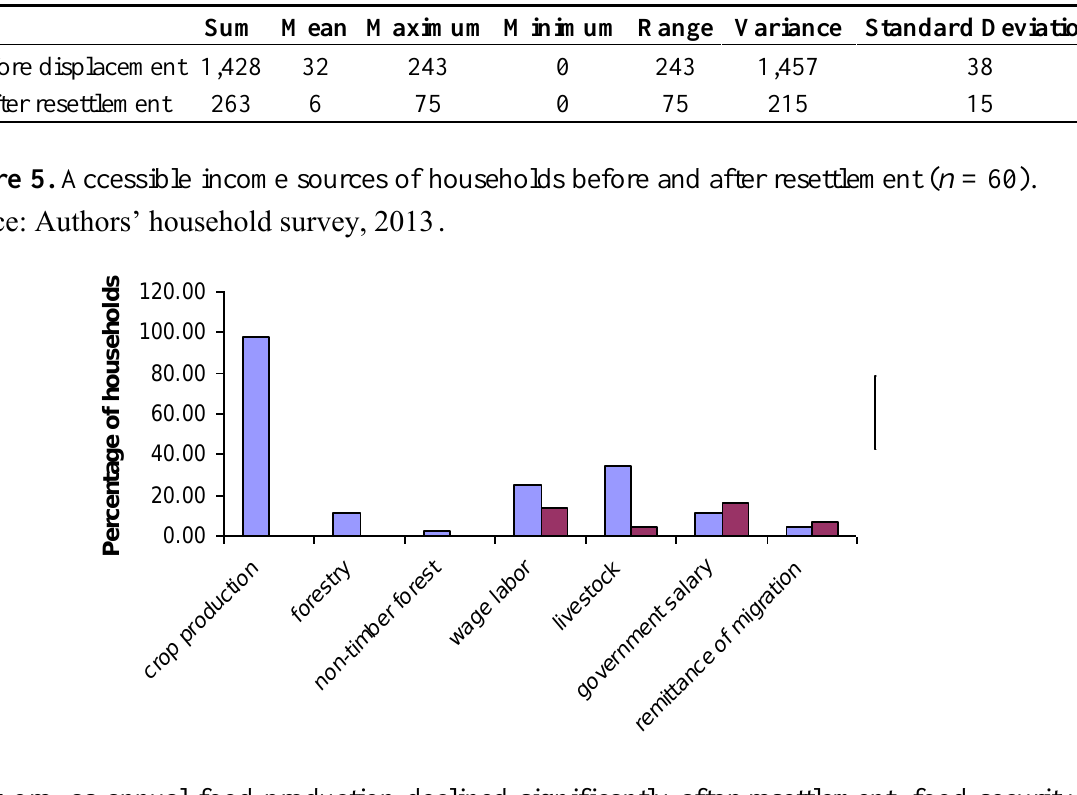
Table 2. Household income distribution before and after resettlement. Unit: VND million (1 USD = 20 VND million). Source: Authors’ household survey, 2013